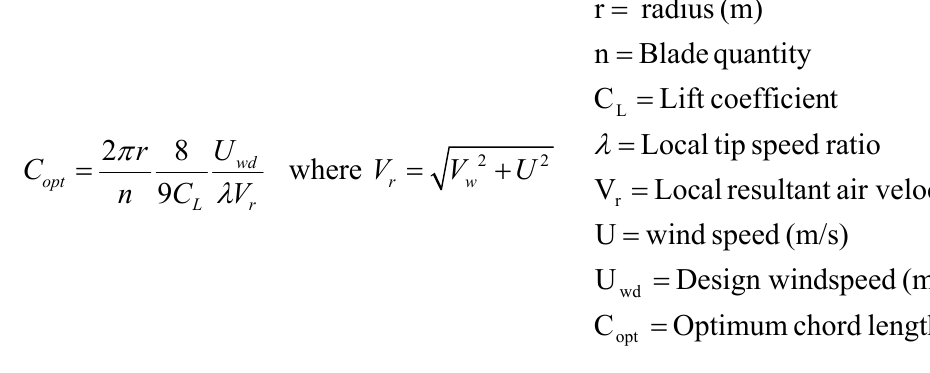
Figure 2. A typical blade plan and region